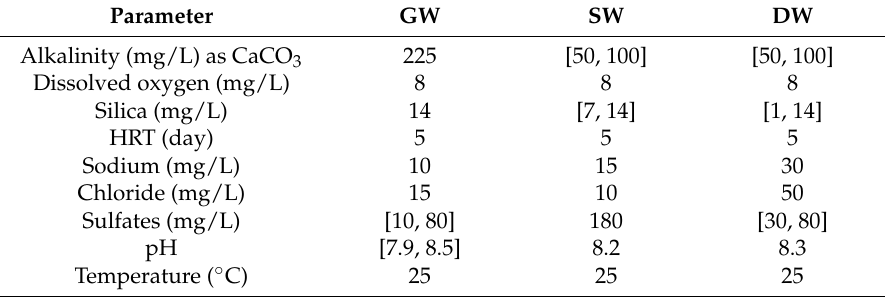
Table 2. Value range of water quality